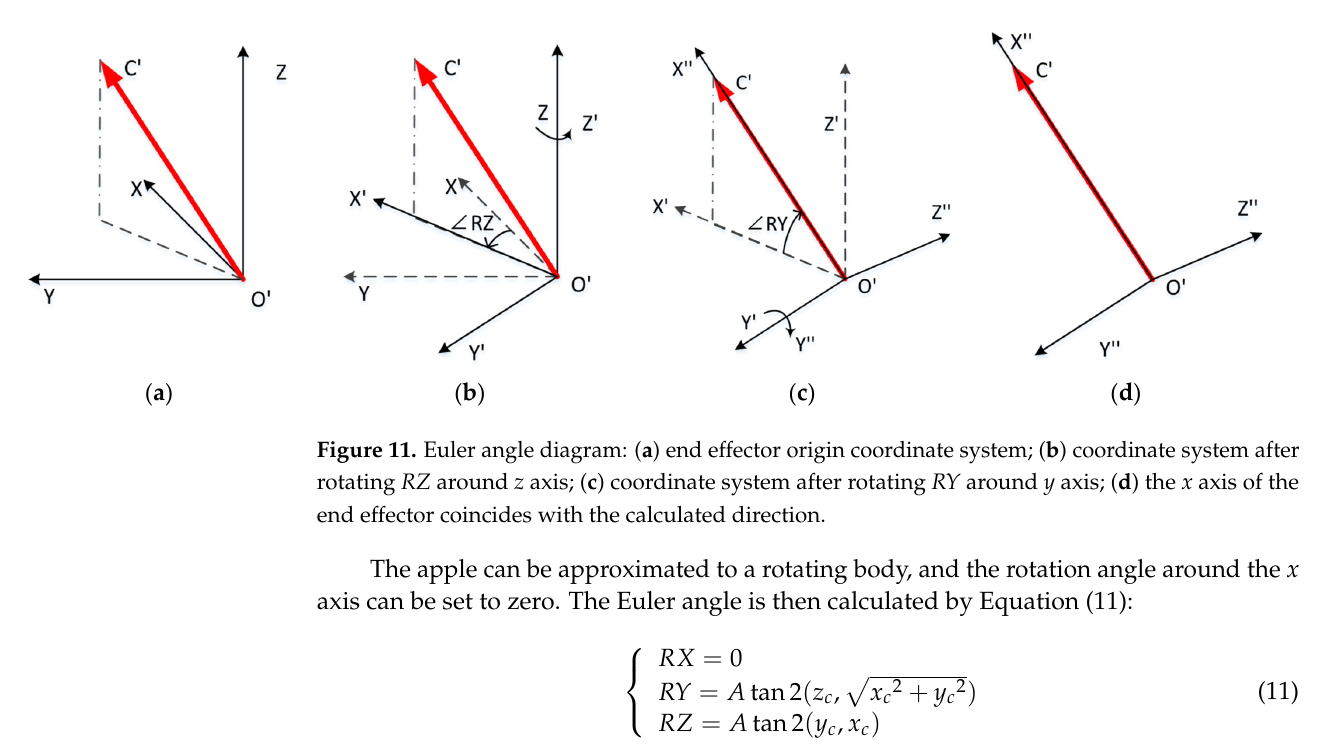
Figure 10. Calculation of the position of the apple relative to the branch: ( a ) OC is the direction vector from the centroid to the line; ( b ) result graph showing useful points and nonuseful points; ( c ) result graph showing only useful points. The red arrow indicates the calculated apple picking direction; the point cloud of the apple surface is pink, the point cloud of the branch nearest to the apple is green, and gray represents other point clouds. Note that the plane of collinearity of A , B , C , and O is not necessarily the plane of this page. (This coloring is used in subsequent figures.). To obtain the Euler angle of the end effector, first, convert the spherical center coor- dinates ),,( ooo zyxO of the sphere and direction vector OC to the end effector coordinate system. The robotic arm will approach the centroid in the direction of the transformed direction vector, ),,( ccc zyxCO ′′ , which is the gripping direction shown in Figure 3b. The transformation is as follows.